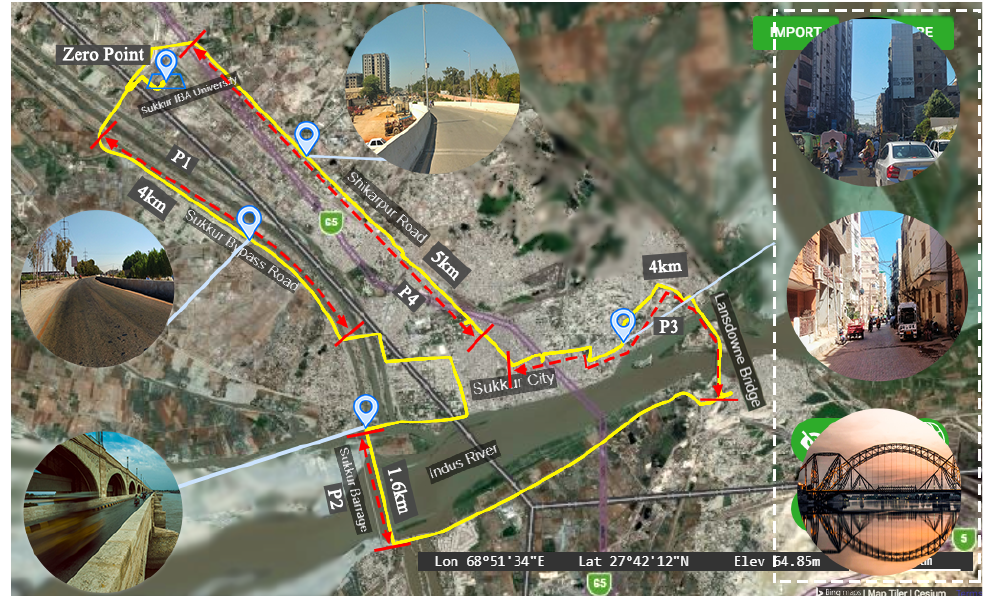
Figure 1. A 30 km long route covering the Sukkur city center and its surroundings used for field experimentation contain various operating environments, such as clear open-sky at the N-65 highway, semi-urban and dense urban areas with small lane widths, high-rise buildings, flyovers and bridges. The total route is divided into four distinct observation windows based on environment characteristics, and these are labeled as P1, P2, P3 and